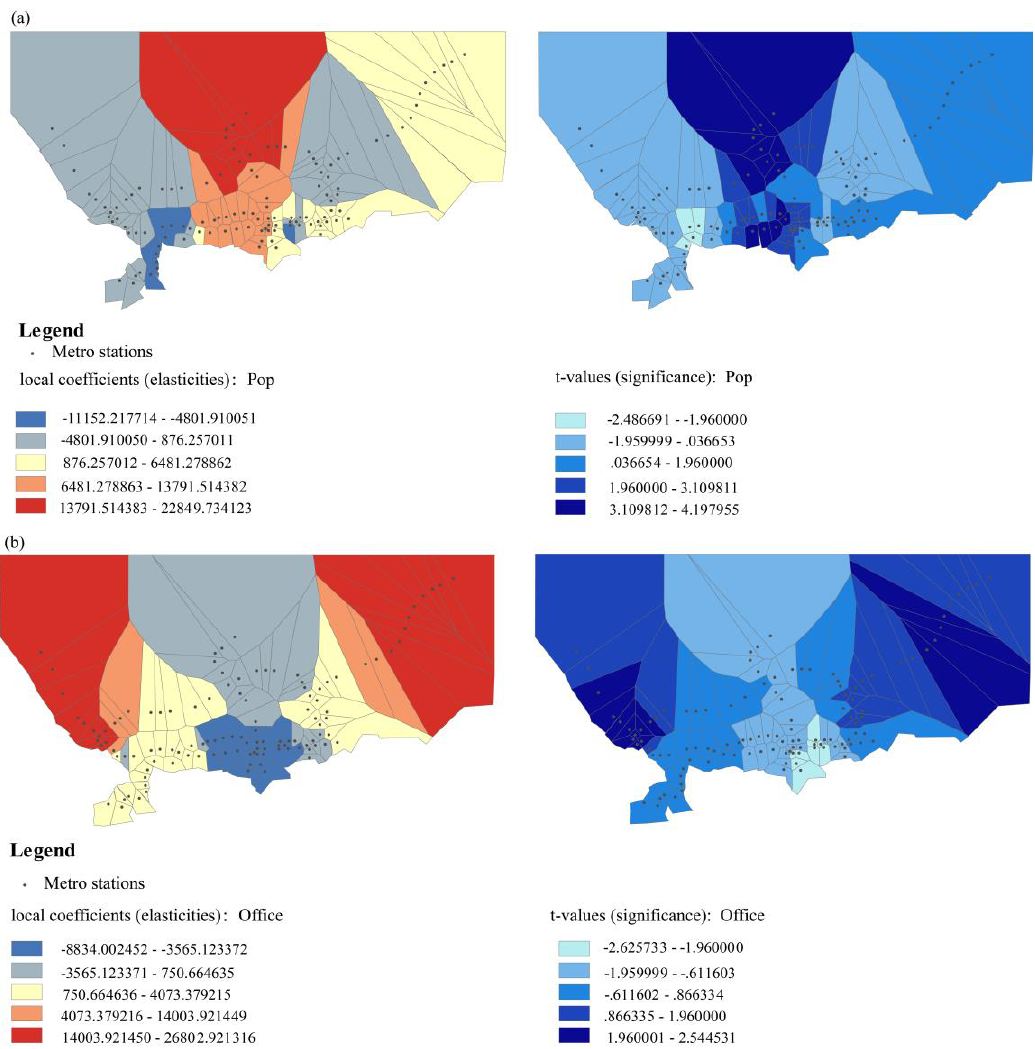
Figure 7. Spatial distribution of local coe ffi cients (elasticities) on weekdays. ( a ) Spatial distribution of local coe ffi cients (elasticities) and t-values (significance) for the population variable. ( b ) Spatial distribution of local coe ffi cients (elasticities) and t-values (significance) for the o ffi ce variable.